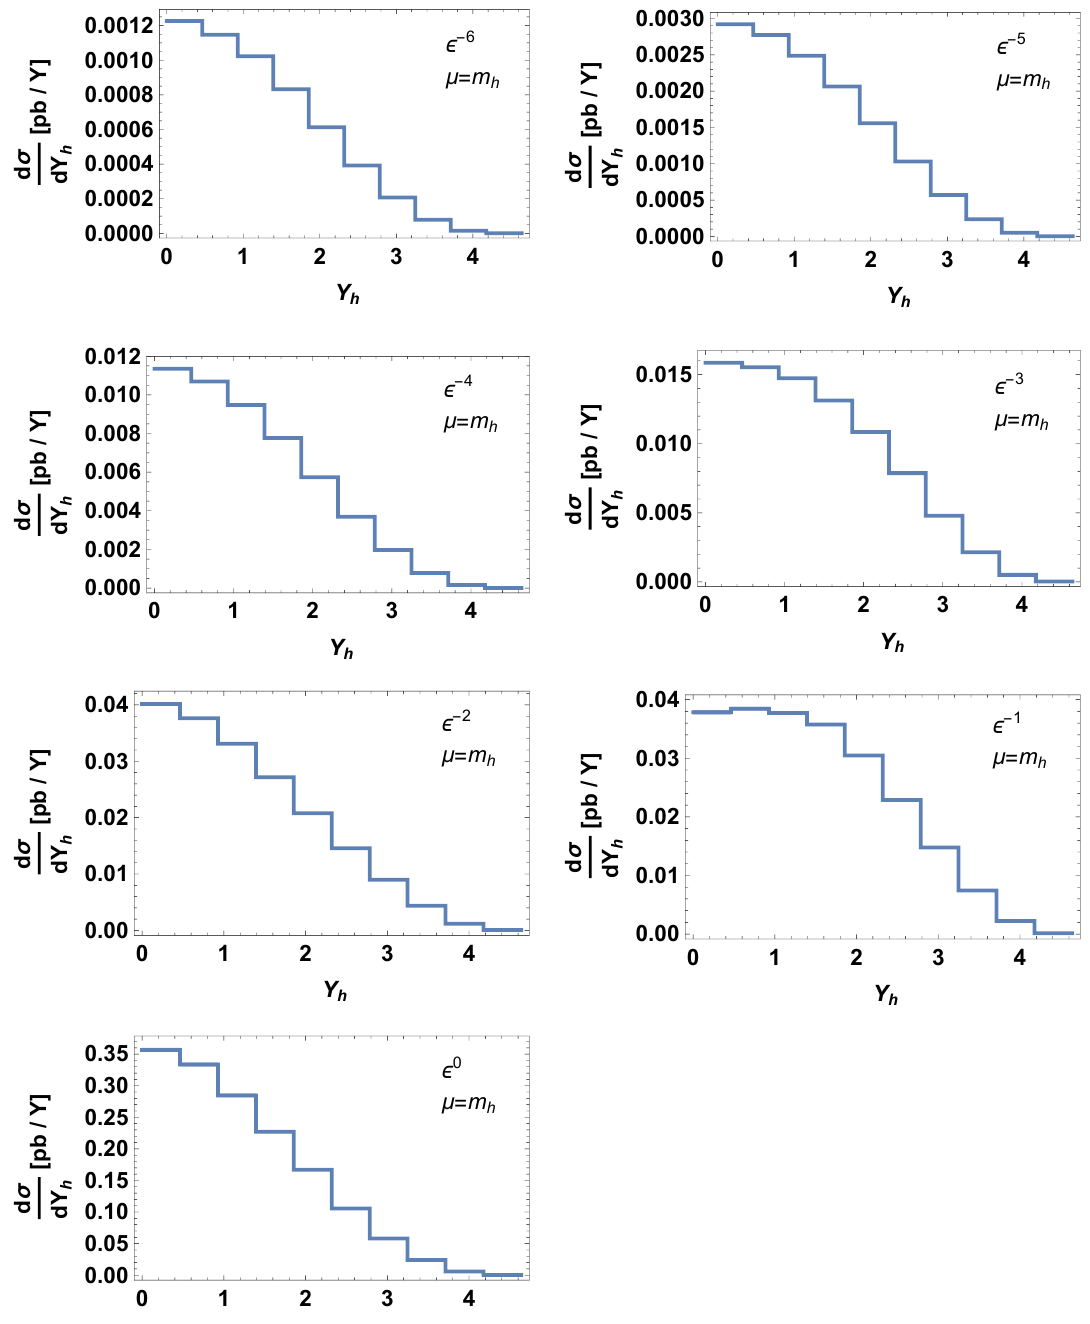
Figure 2 . Distributions for the Higgs rapidity Y h for each pole in the dimensional regulator " . The bands in the bins correspond to numerical uncertainties.